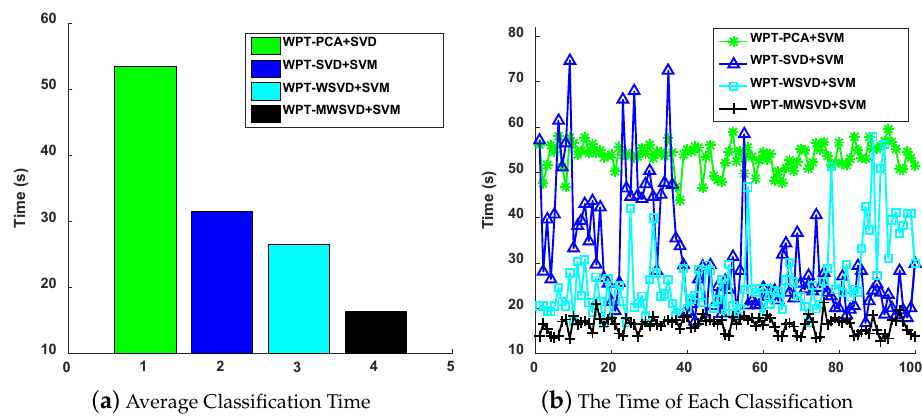
Figure 10. The average classification time of 100 runs ( a ) and each classification time ( b ).